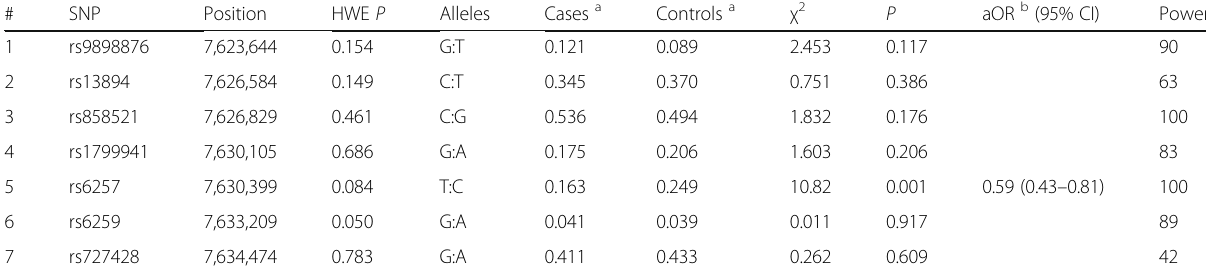
Table 2 SHBG SNPs analyzed in RPL cases and control women